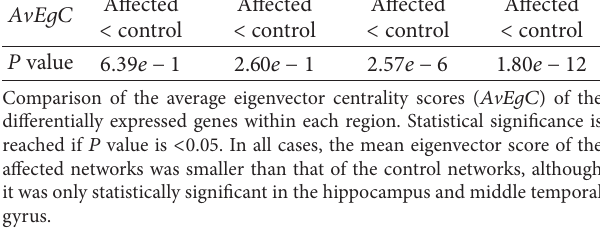
Table 8: Comparison of mean eigenvector centrality scores ( 𝐴 V 𝐸𝑔𝐶 ) of DE genes in control and affected coexpression networks per region. Region EC PCC HIP MTG Affected Affected Affected 𝐴 V 𝐸𝑔𝐶 Affected < control < control < control < control 𝑃 value 6.39𝑒 − 1 2.60𝑒 − 1 2.57𝑒 − 6 1.80𝑒 −